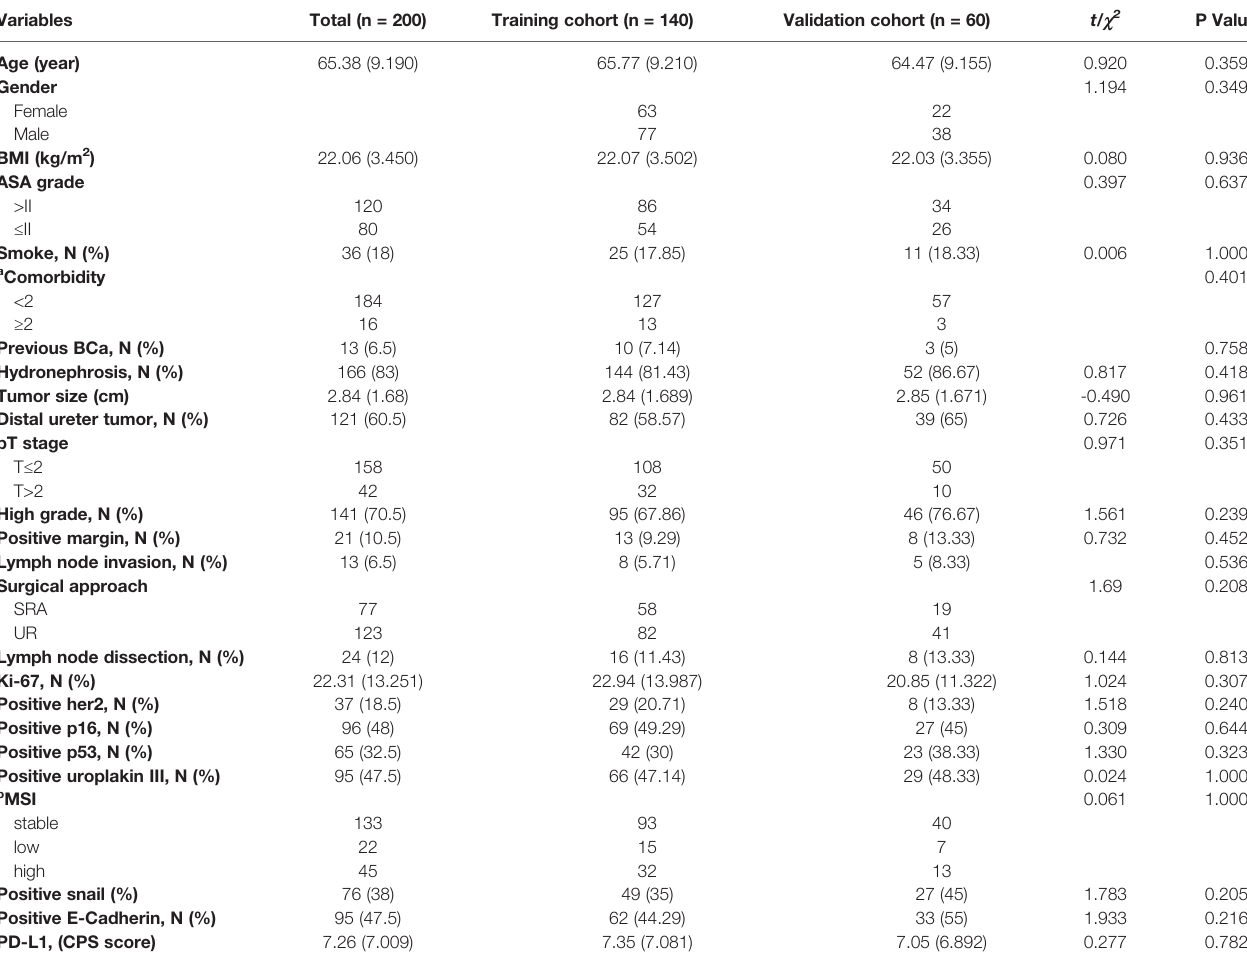
TABLE 1 | Characteristics of patients with UTUC after kidney-sparing surgery.